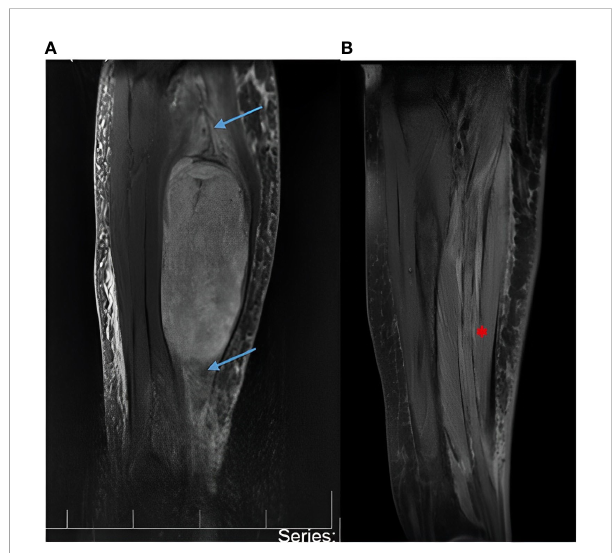
FIGURE 1 (A) Magnetic resonance imaging (MRI) with gadolinium showing a large malignant peripheral nerve sheath tumor (13x8x7cm) of the median nerve at the level of the forearm. The blue arrows show the median nerve proximal and distal to the tumor. The nerve appears enlarged due to the tumor growing in its context. The white arrow shows the tumor. (B) Postoperative MRI with gadolinium at 30 days postoperatively and every 6 months thereafter documented absence of tumor recurrence or remnants. The red arrow shows postoperative integrity of the median